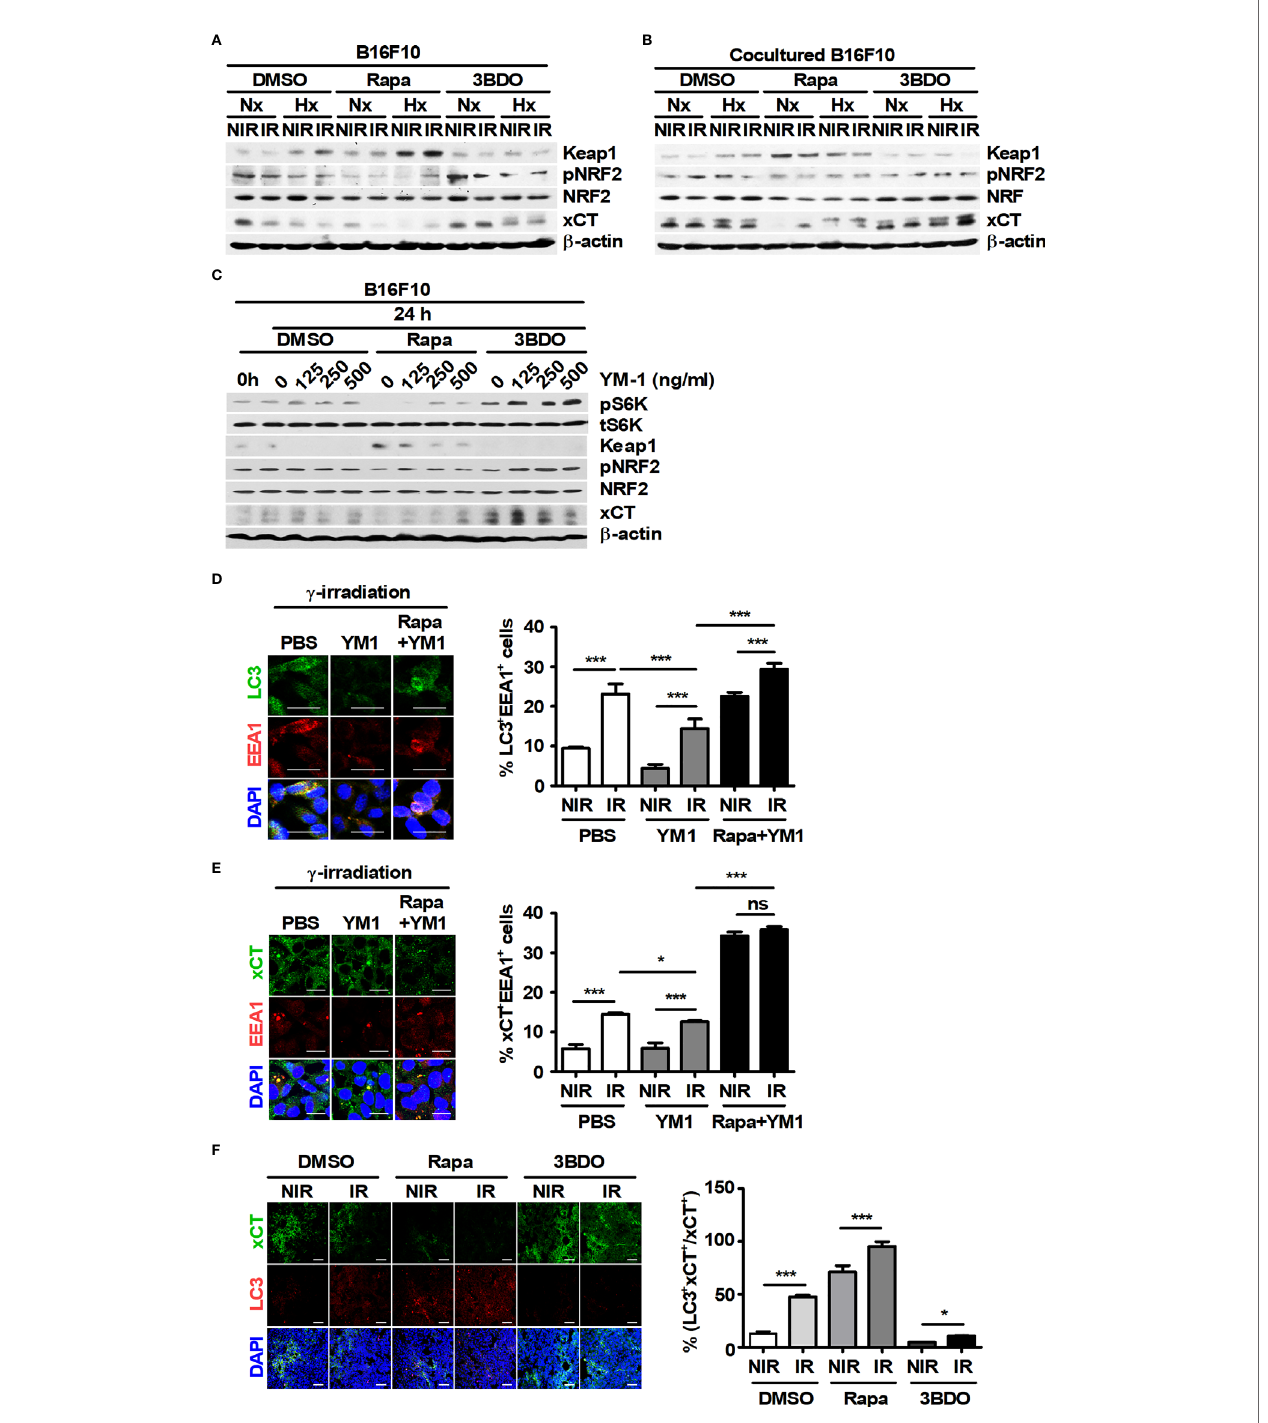
FIGURE 6 | Pharmaceutical regulation of mTOR activation affects the functional expression of xCT in B16F10 cells. (A, B) B16F10 cells cultured alone or cocultured with BMDMs were treated with DMSO, 100 nM rapamycin or 100 nM 3BDO under the indicated conditions. Intracellular levels of Keap1, phospho-NRF2, NRF, xCT, and b -actin in B16F10 cells were evaluated by western blotting. (C – E) B16F10 cells were treated with DMSO, 100 nM rapamycin or 100 nM 3BDO for 3 h and then stimulated with the indicated concentrations of recombinant mouse YM-1 for 21 h. (C) The expression levels of phospho-p70 S6K, p70 S6K, Keap1, phospho- NRF2, NRF, xCT, and b -actin in B16F10 cells were detected by western blotting. (D, E) Intracellular levels of LC3, EEA1, and xCT were assessed by confocal microscopy. Scale bars, 30 m m. (F) Intratumoral levels of xCT and LC3 were analyzed by confocal microscopy. All images were quanti fi ed using ImageJ. Scale bars, 200 m m. The bars and error bars represent the mean ± SD; * P < 0.05; *** P < 0.001; ns, not signi fi